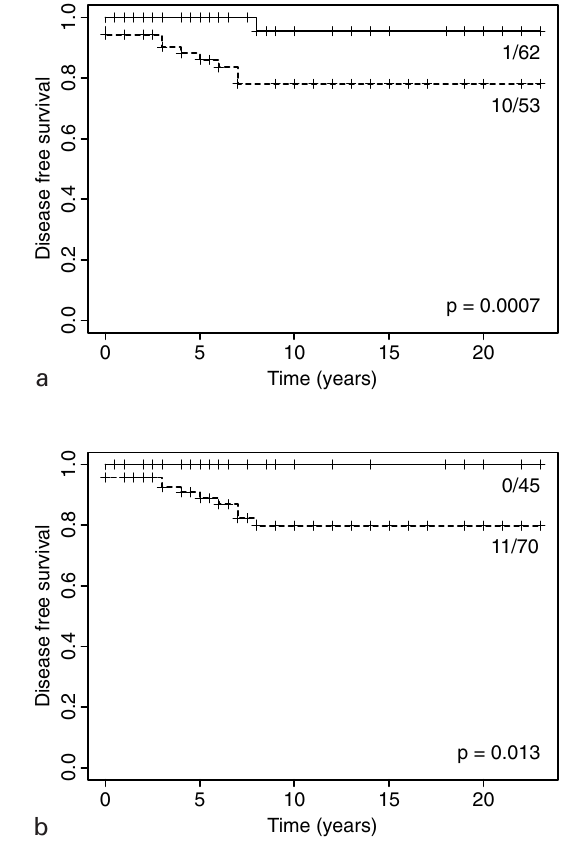
ma), but not mi- 4